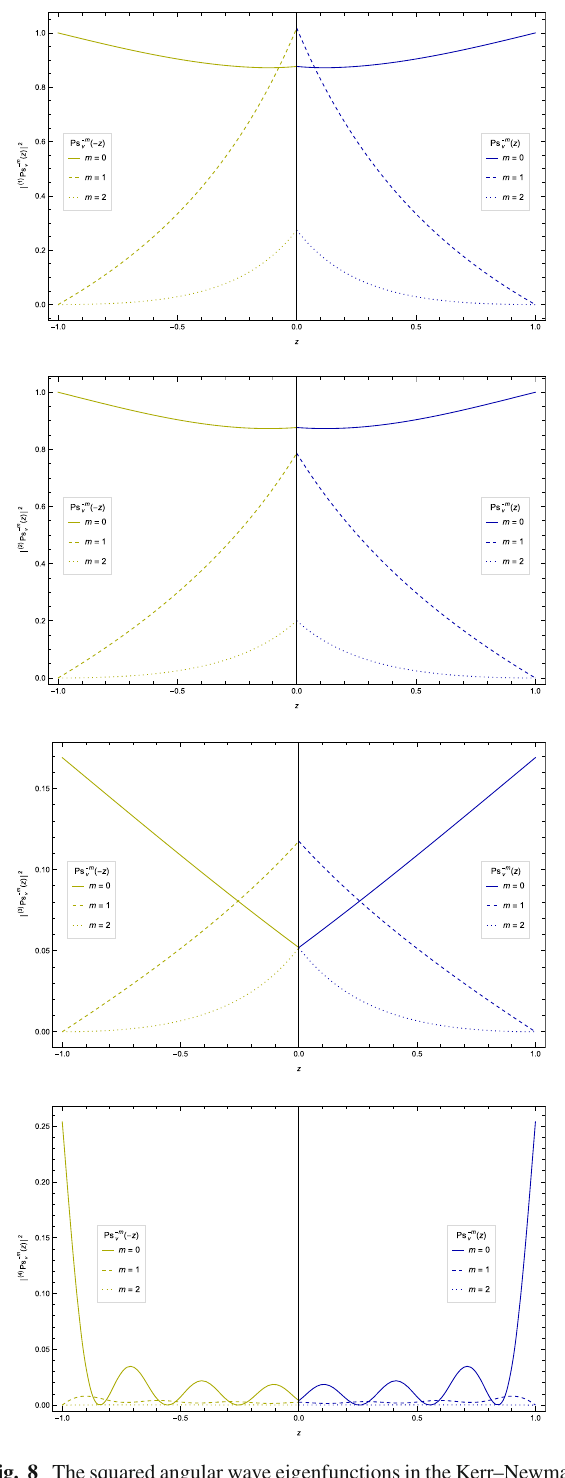
Fig. 8 The squared angular wave eigenfunctions in the Kerr–Newman blackholespacetimeforthefundamentalmode N = 0,with M μ = 0 . 5, a = 0 . 1, e = 0 . 01, and Q = 0 . 1, where z = cos θ . The units are in multiples of ( j ) C − m